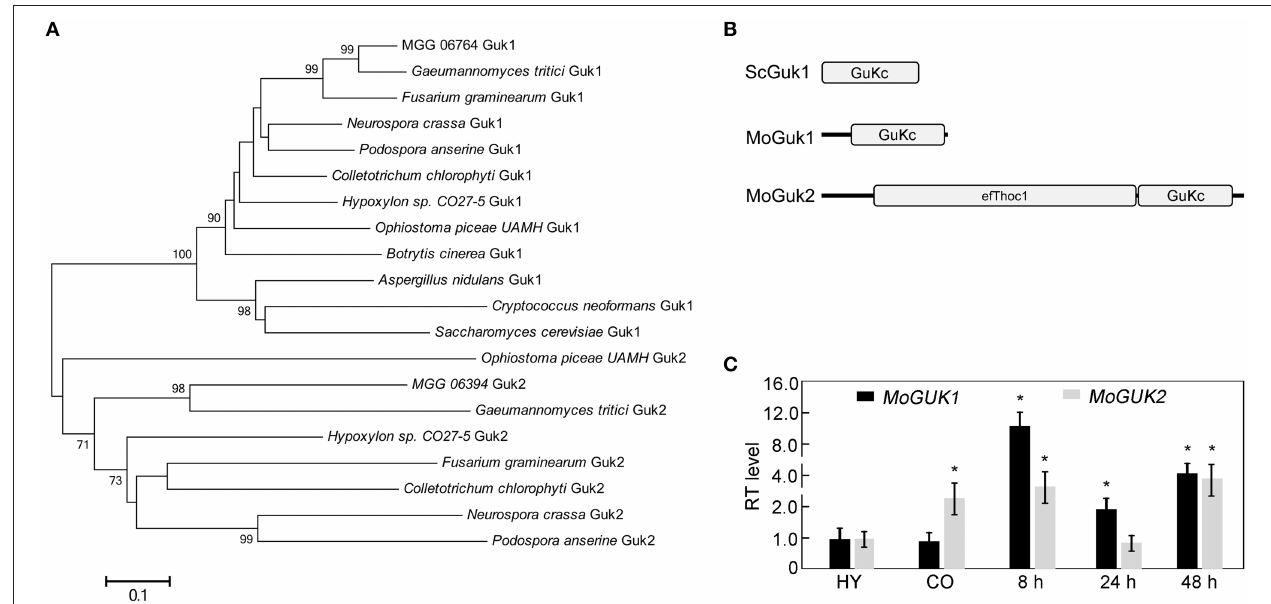
FIGURE 2 | Phylogenetic analysis of Guk proteins from different organisms. (A) The homologs of ScGuk1 in M. oryzae were identified using blastp program and 1e-40 as an e -value cut-off. To construct the tree, homolog sequences retrieved from GuKc domains of MoGuk1 and MoGuk2 families in other indicated species were identified using blastp program default parameters. The tree was constructed using MEGA 5, with the Neighbor-Joining method and default parameters, bootstrap values > 65 were displayed beside the braches. (B) The GuKc domains were predicted using SMART server (http://smart.embl-heidelberg.de). (C) Quantitative RT-PCR analysis the expression of MoGUK1 and MoGUK2 . Total RNA was extracted from mycelia (MY), conidia (CO), and infectious hyphae of the wild type Guy11. Error bars represent standard deviation and asterisks represent significant differences at P <